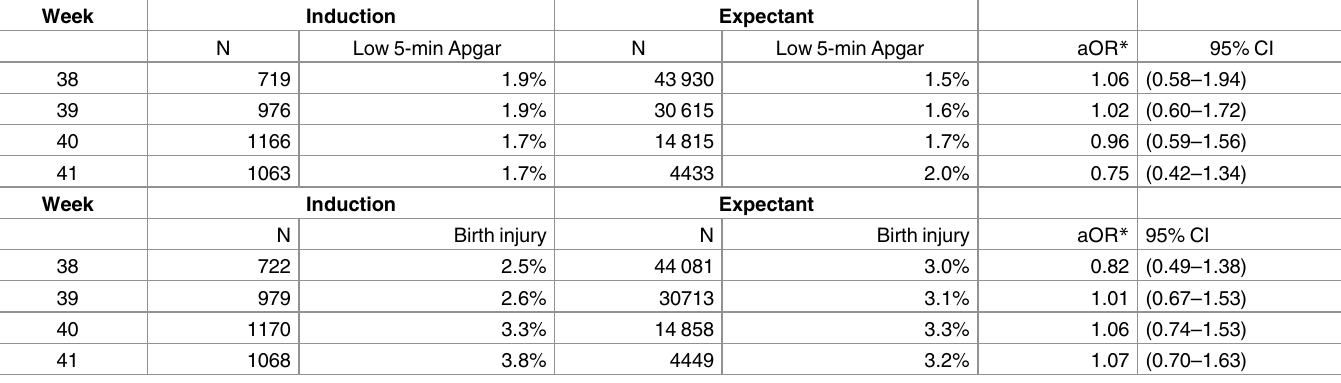
Table 4. Risk of five-minute Apgar score less than seven and birth injury among pregnancies with large for gestational age infants depending on management with induction at 38 to 41 completed gestational weeks or expectant management with labor at next gestational week or